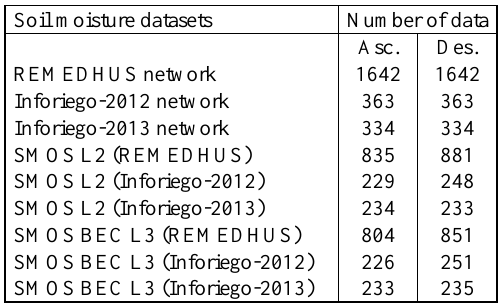
Table 1. Number of data for each